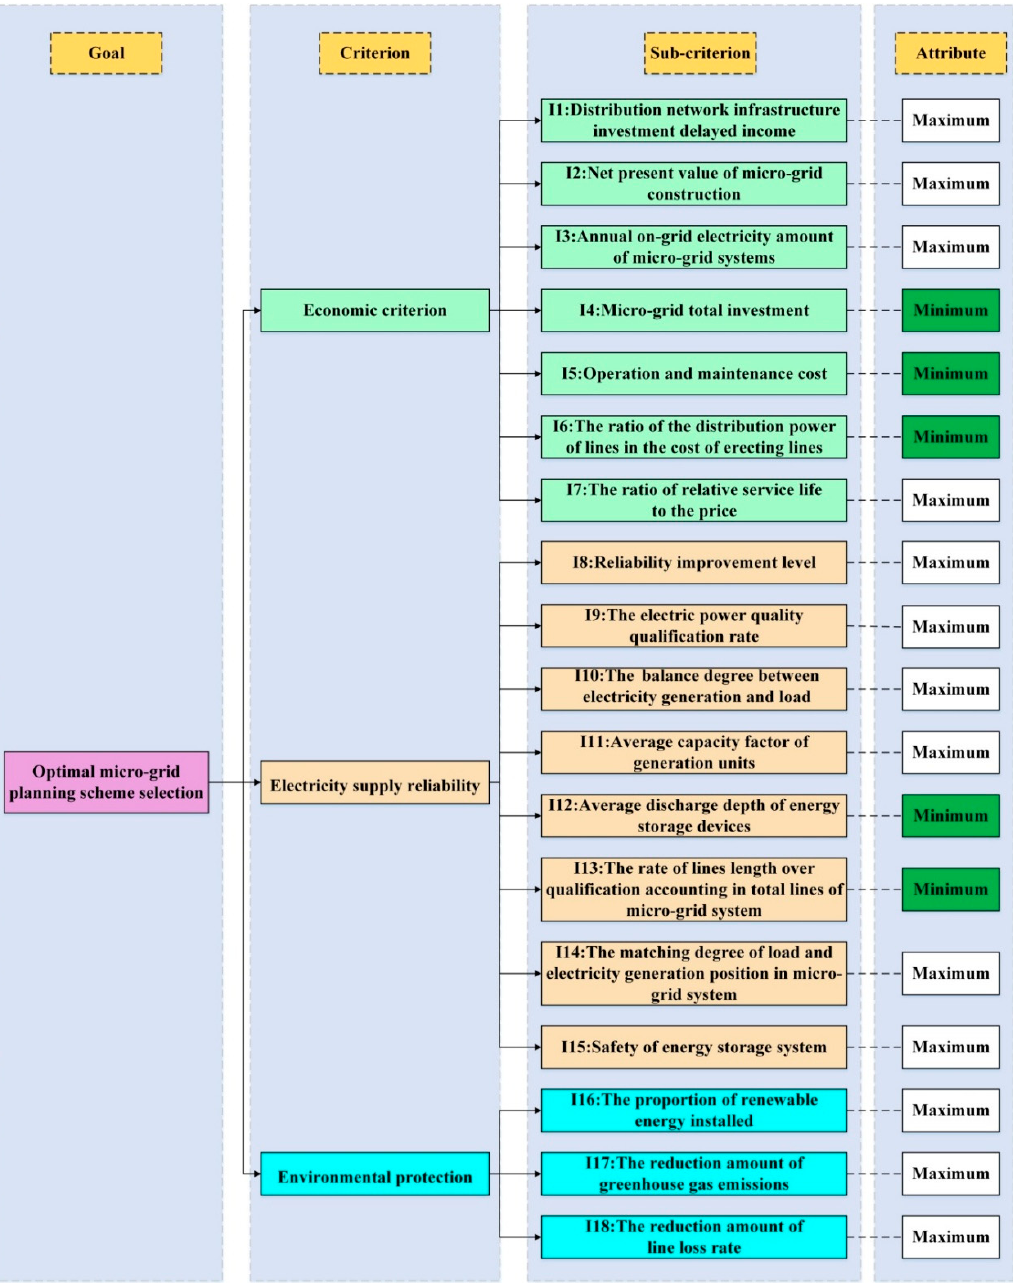
Figure 2. The constructed evaluation index system for the optimal micro-grid planning program selection.